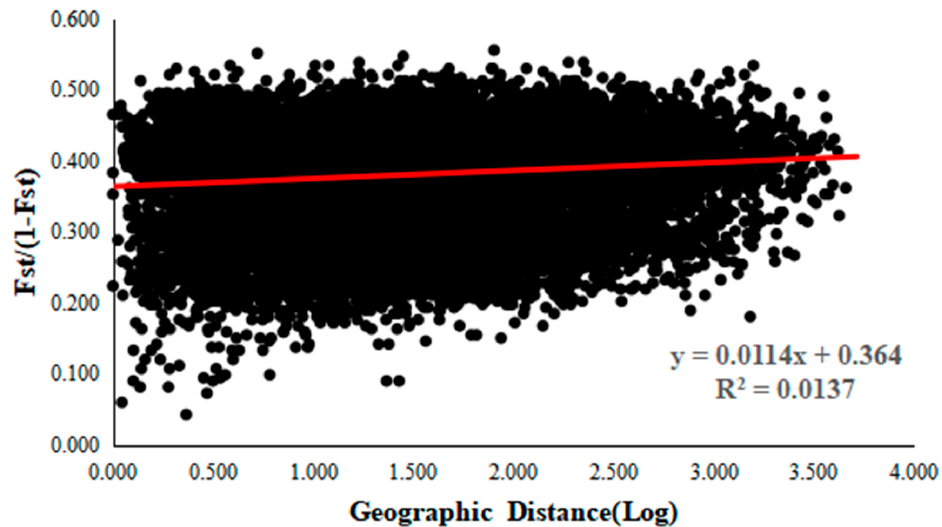
Figure 2. Mantel correlation between the genetic and geographic distances.